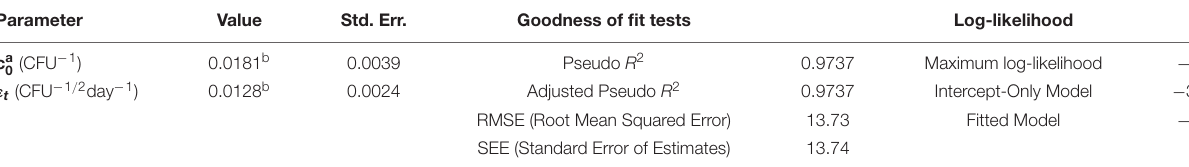
TABLE 5 | Estimation and related regression statistics of ν model (Eq. 13) parameters.